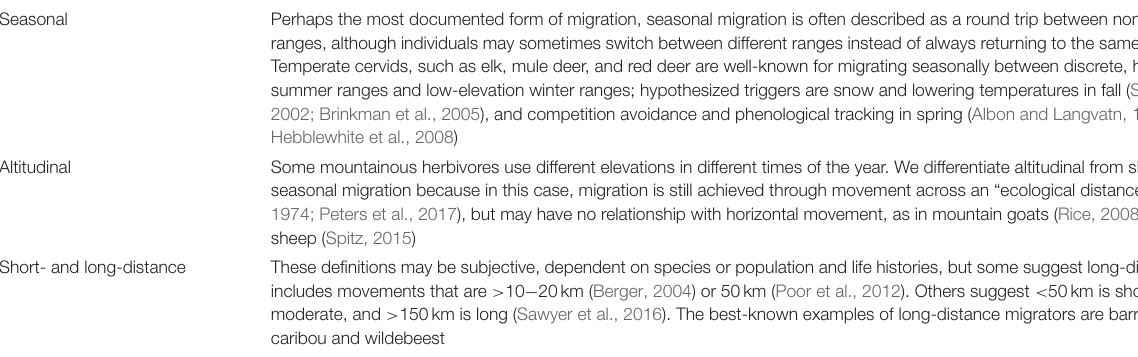
TABLE 2 | The different forms of migration in